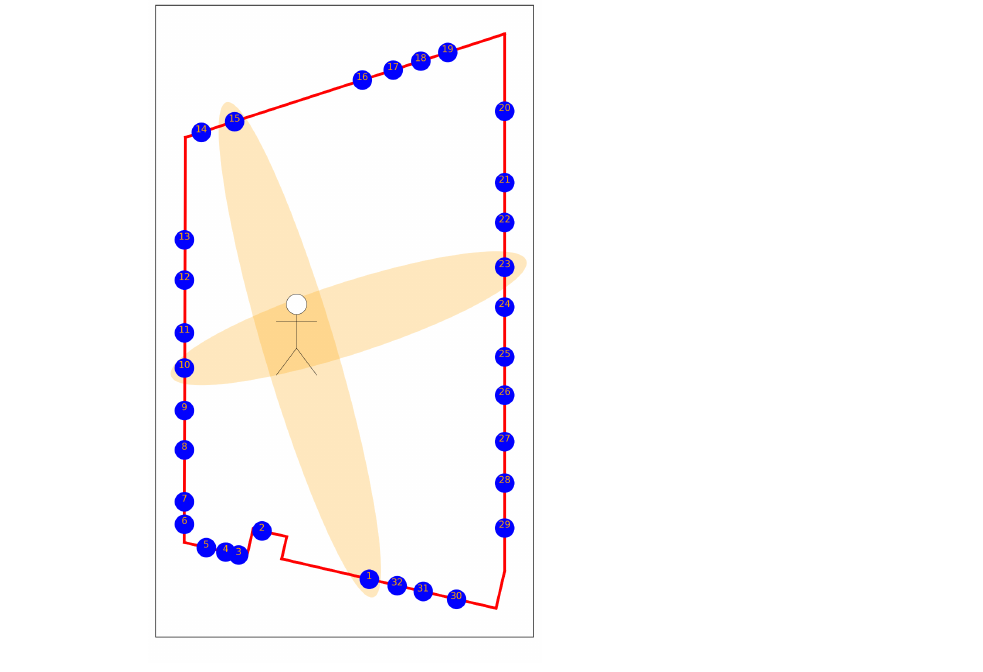
Figure 12. RTI setup with elliptical weight model on the contour of the test room.